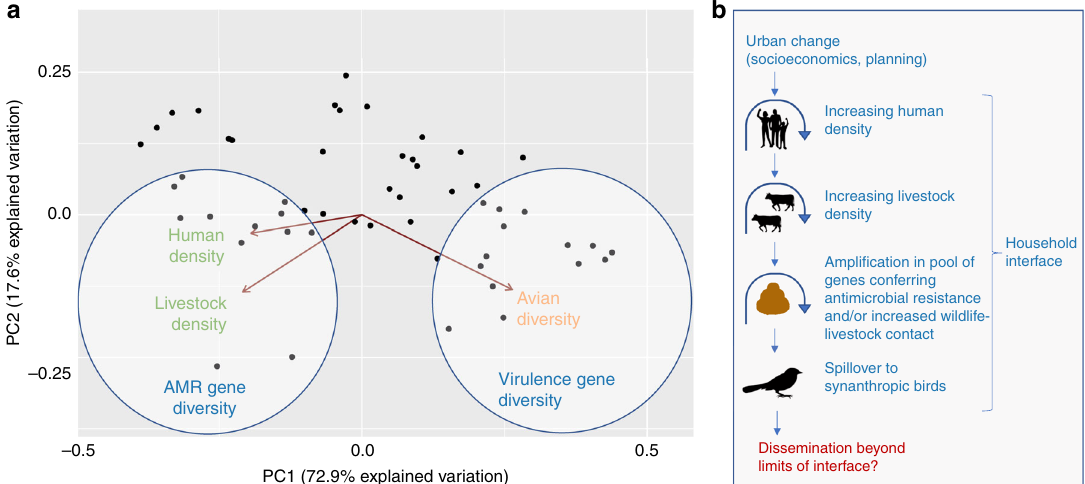
Fig. 3 Epidemiological gradients in MGE diversity, and pathways to AMR spillover under urban change. a Diagrammatic representation of how epidemiological gradients in diversity (richness) of virulence and AMR genes in avian-borne E. coli overlay on broad-scale trends in host community characteristics at urban household interfaces. The characteristics of host communities are represented in the form of a principal components analysis (PCA), performed on avian diversity (species richness), human density and livestock density in households. PC1 accounts for most variation, separating households with high avian diversity from households with high human and livestock density. Associations between the diversity of virulence and AMR genes, and avian diversity human density and livestock density are indicated by circles overlaid onto the PCA biplot. b Schematic illustrating possible processes leading to spillover of AMR genetic determinants between livestock and synanthropic birds at household